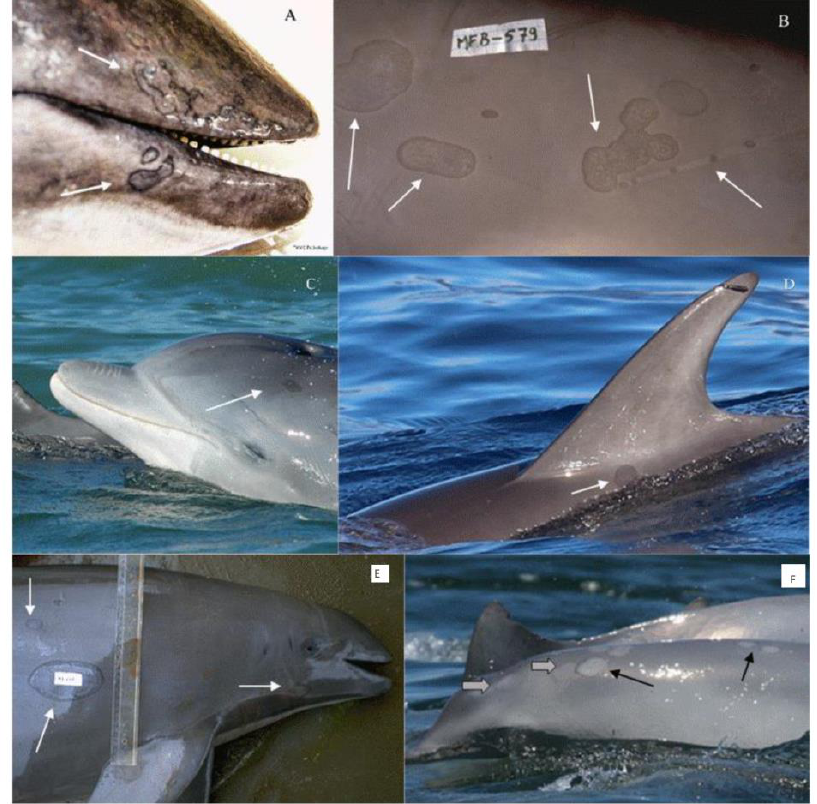
Figure 1. Tattoo skin lesions in ( A ) a harbour porpoise ( Phocoena phocoena ) from the north-central coast of California; ( B ) a dusky dolphin ( Lagenorhynchus obscurus ) caught off central Peru; ( C ) in a free-ranging common bottlenose dolphin ( Tursiops truncatus ) from the Pato Lagoon estuary, Brazil (courtesy of P. Fruet ); ( D ) in a free-ranging Atlantic spotted dolphin ( Stenella frontalis ) from La Gomera, Canary Islands, Spain (courtesy of F. Ritter ); ( E ) medium-sized and very large lesions in a Burmeister’s porpoise ( Phocoena spinipinnis ) from Peru; and ( F ) resolving lesions (black arrows) and tattoo remains (gray arrows) in a Guiana dolphin ( Sotalia guianensis ) from Sepetiba Bay, Brazil (cour- tesy of L. Flach ).